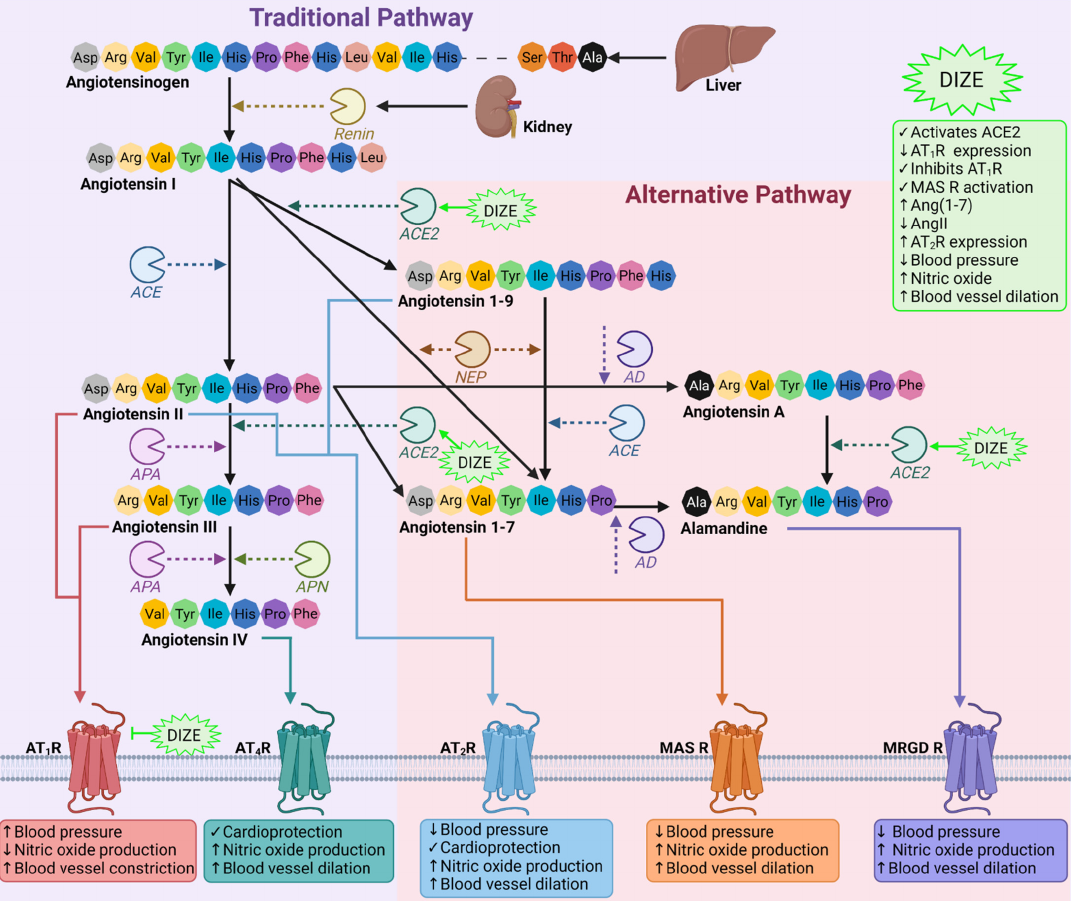
Figure 1. Schematic diagram of the RAS and DIZE’s proposed involvement. The RAS comprises two arms: the classical and alternative axes. In the classical axis, angiotensinogen produced by the liver is cleaved by renin to produce angiotensin I (AngI) [3]. AngI is then acted upon by angiotensin converting enzyme to produce AngII, which can associate with AT 1 R to increase the blood pressure, reduce nitric oxide production (the most potent endogenous vasodilator) and promote vasocon- striction. Additionally, AngII can bind to and activate the counterregulatory AT 4 R and AT 2 R, the latter of which is part of the alternative axis [3]. AngII can further be processed by aminopeptidase A (APA) to form angiotensin III (AngIII), which, in turn, can be cleaved by either APA or alanyl aminopeptidase to form angiotensin IV (AngIV). Both AngIII and AngIV are able to bind and acti- vate AT 1 R, resulting in pathogenic cardiovascular consequences [3]. Alternatively, AngI can also be cleaved by ACE2 to produce angiotensin 1–9 (Ang(1–9)) or by neprilysin to generate Ang(1–7) [3]. Ang(1–9) and Ang(1–7) are both cardioprotective, and their association with AT 2 R or MAS R results in the opposing effects of AT 1 R. Ang(1–7) can also be produced from the ACE2 cleavage activity of AngII and can further be metabolized by aspartate decarboxylase (AD) into alamandine, which en- gages with MRGD R. AD is also able to cleave AngII to produce angiotensin A, which can be con- verted into alamandine by ACE2 [3]. DIZE is a putative ACE2 activator and AT 1 R inhibitor, which has been shown to directly cause vasodilation by increasing the nitric oxide production and MAS R activation, reduces the blood pressure and increases the cardioprotective peptides Ang(1–7) and AT 2 R [11,17,19]. Figure was made using biorender.com (accessed on 12 July 2022). Abbreviations : ACE, angiotensin-converting enzyme; ACE2, angiotensin-converting enzyme 2; AD, aspartate de- carboxylase; APA, aminopeptidase A; APN, alanyl aminopeptidase; AT 1 R, angiotensin type 1